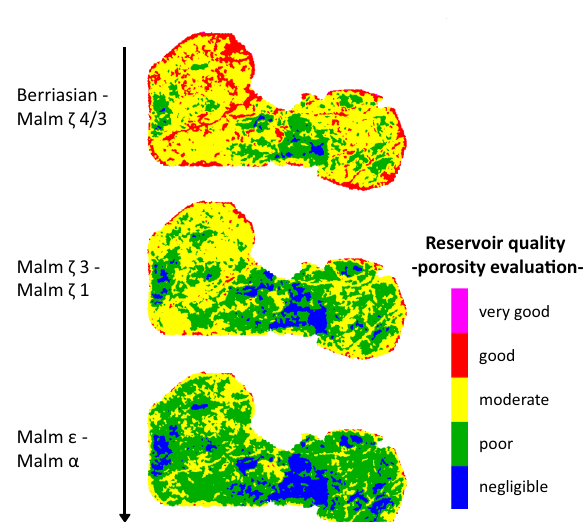
Fig. 16 Map view of reservoir quality based on porosity evaluation for three different zones: Berriasian to Malm ζ 4/3, Malm ζ 3 to Malm ζ 1, and Malm ε to Malm α . The stratigraphic subdivision is based on the sequence stratigraphic interpretation for the geothermal site SLS by Wolpert et al. (2020). It has to be noted that this reservoir quality estimation is just based on a porosity evaluation and no permeability values are included. According to Homuth (2014), Bohnsack et al. (2020) and Moeck et al. (2020), not only porosity, but also permeability in the GMB is characterized by strong heterogeneity, and they have shown that no general trend describing the porosity–permeability relationship based on stratigraphic units or lithology can be